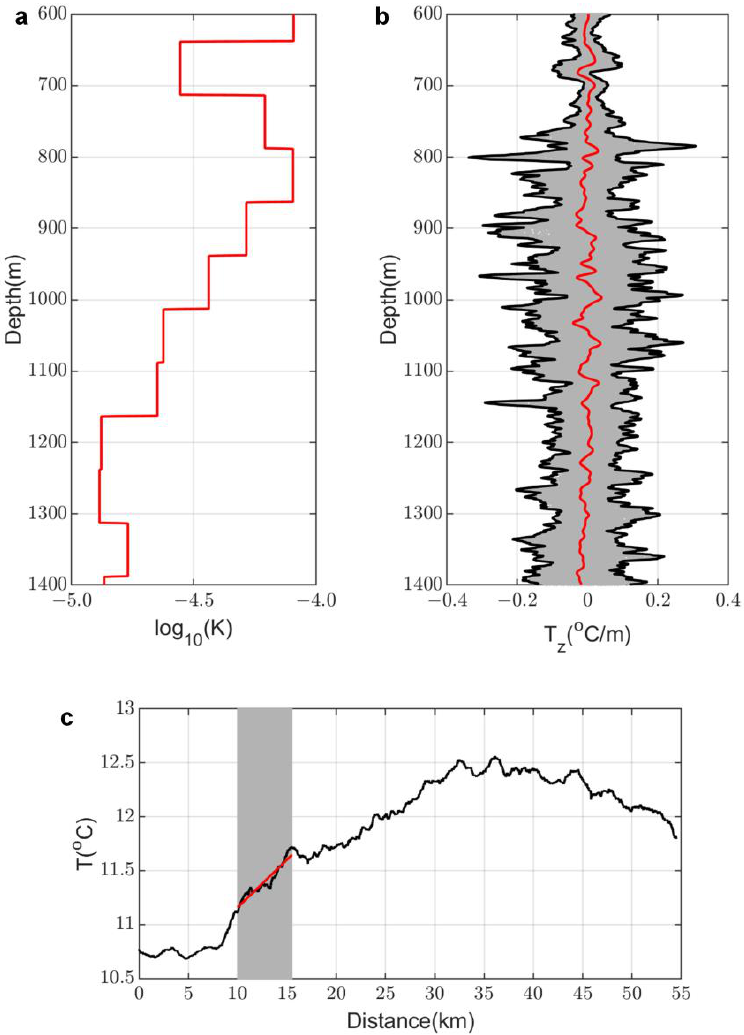
Figure 12. Inside the lateral intrusive region, profiles of ( a ) diapycnal diffusivity with depth ( b ) vertical temperature gradient 𝑇 𝑧 with step of 1 m. Grey area represents the raw 𝑇 𝑧 calculated from inverted temperature profiles at the left edge of the meddy, while black lines are the range of 𝑇 𝑧 and the red line is the average. ( c ) The vertically averaged temperature profile versus distance. The grey area indicates the lateral intrusion area, and the red line represents the best fit line 𝑇 𝑥 .